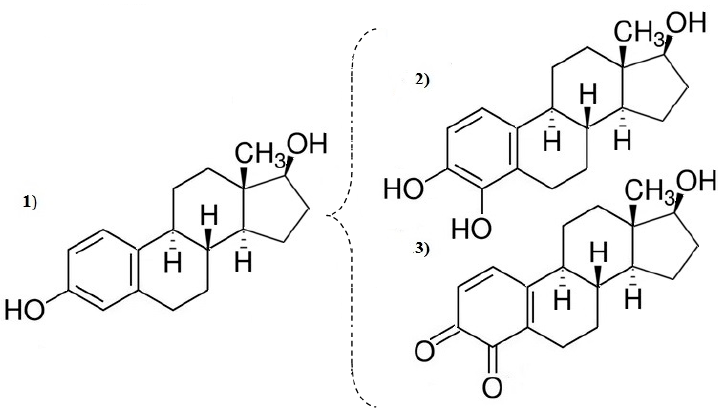
Figure 13. Identified 1 β -estradiol by-products, where 2 is 2-hydroxyestradiol and 3 is (17 β )-17-Hydroxyestra-1,5(10)-diene-3,4-dione.